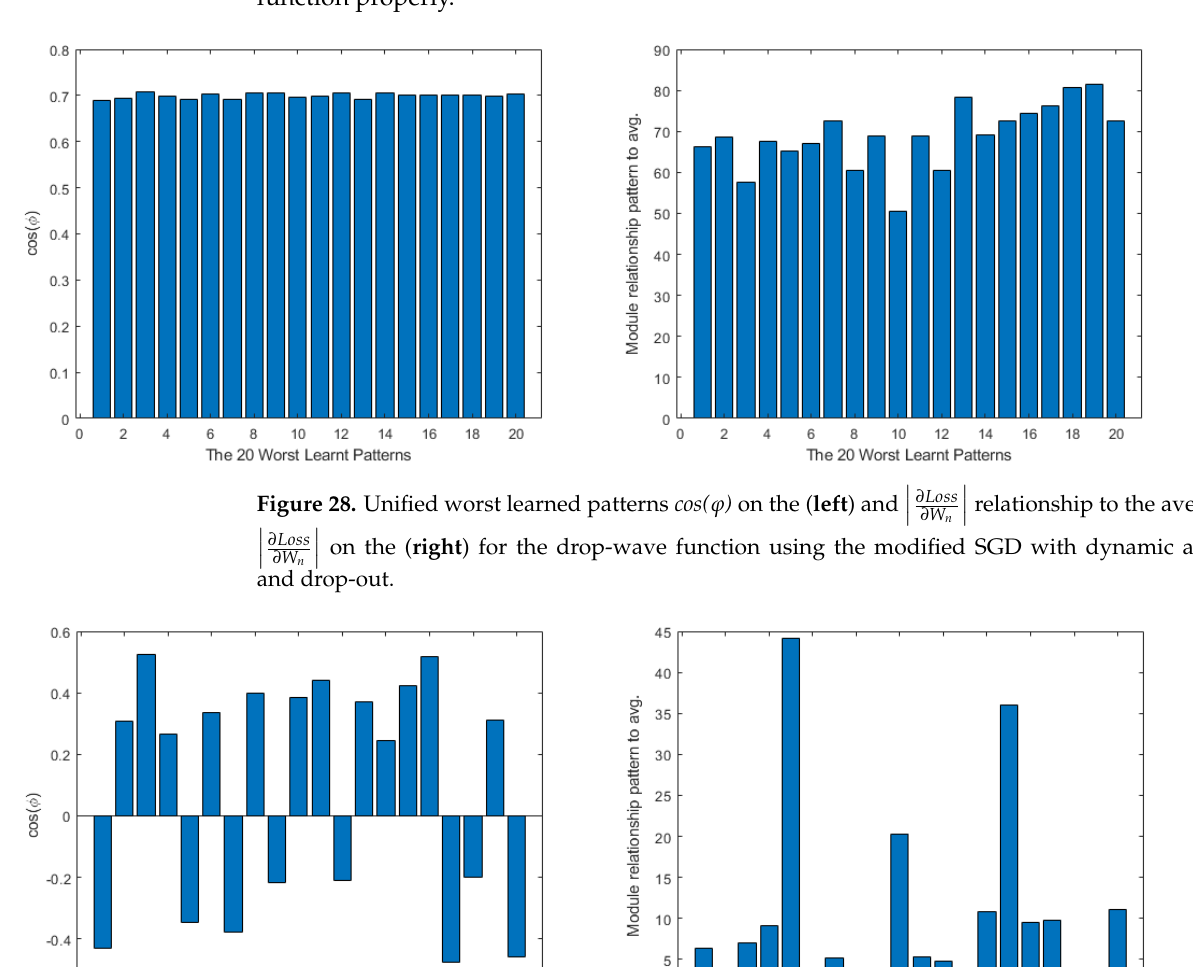
(cid:12) (cid:12) 𝜕𝐿𝑜𝑠𝑠 ∂ Loss (cid:12) (cid:12) | relationship to the average (cid:12) (cid:12) relationship to the average ∂ W n 𝜕𝑊 𝑛